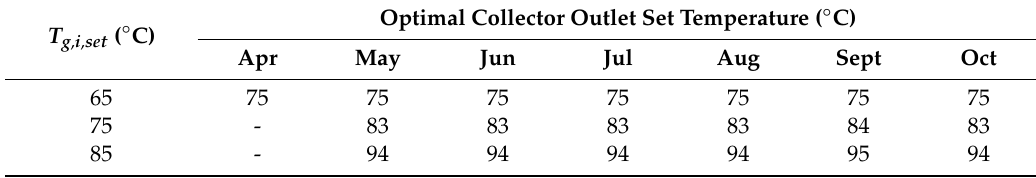
Table 4. Optimal T c , o , set for di ff erent T g , i , set .